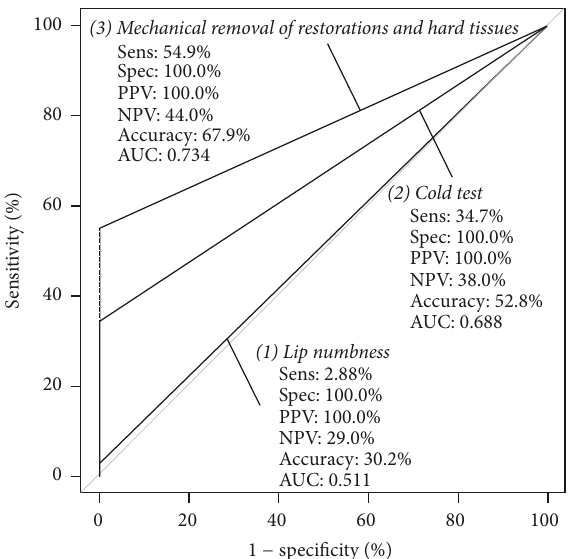
Figure 2: ROC curve analyses for the diagnostic tests.